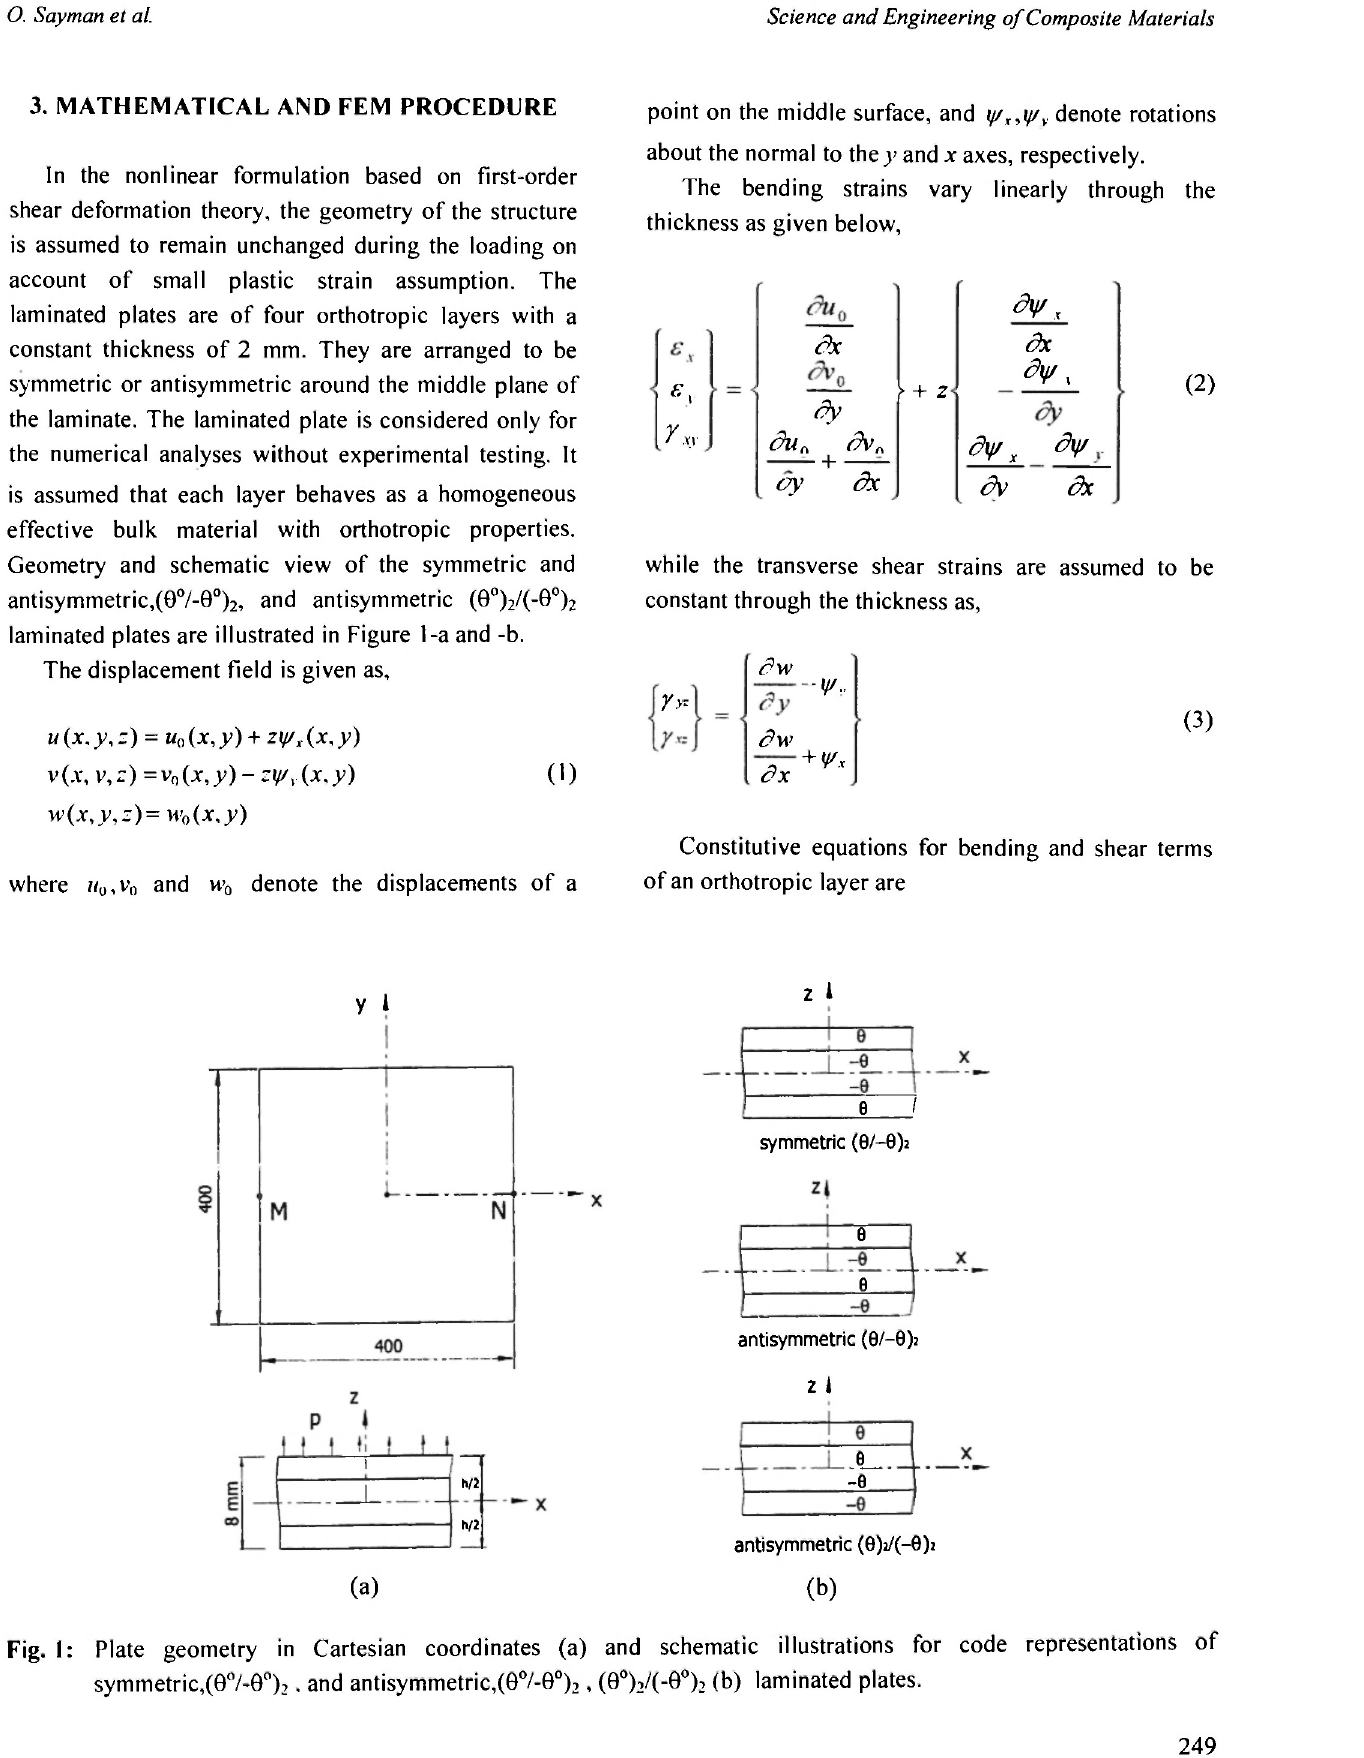
Fig. I: Plate geometry in Cartesian coordinates (a) and schematic illustrations for code representations of symmetric,(θ°/-θ°) 2 . and antisymmetric,(θ°/-θ°) 2 , (θ°) 2 /(-θ °)2 (t>) laminated